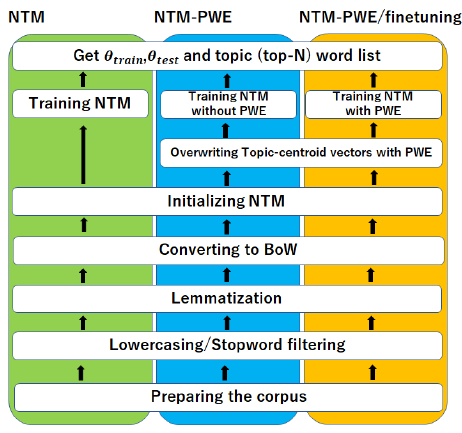
Figure 1. Proposed